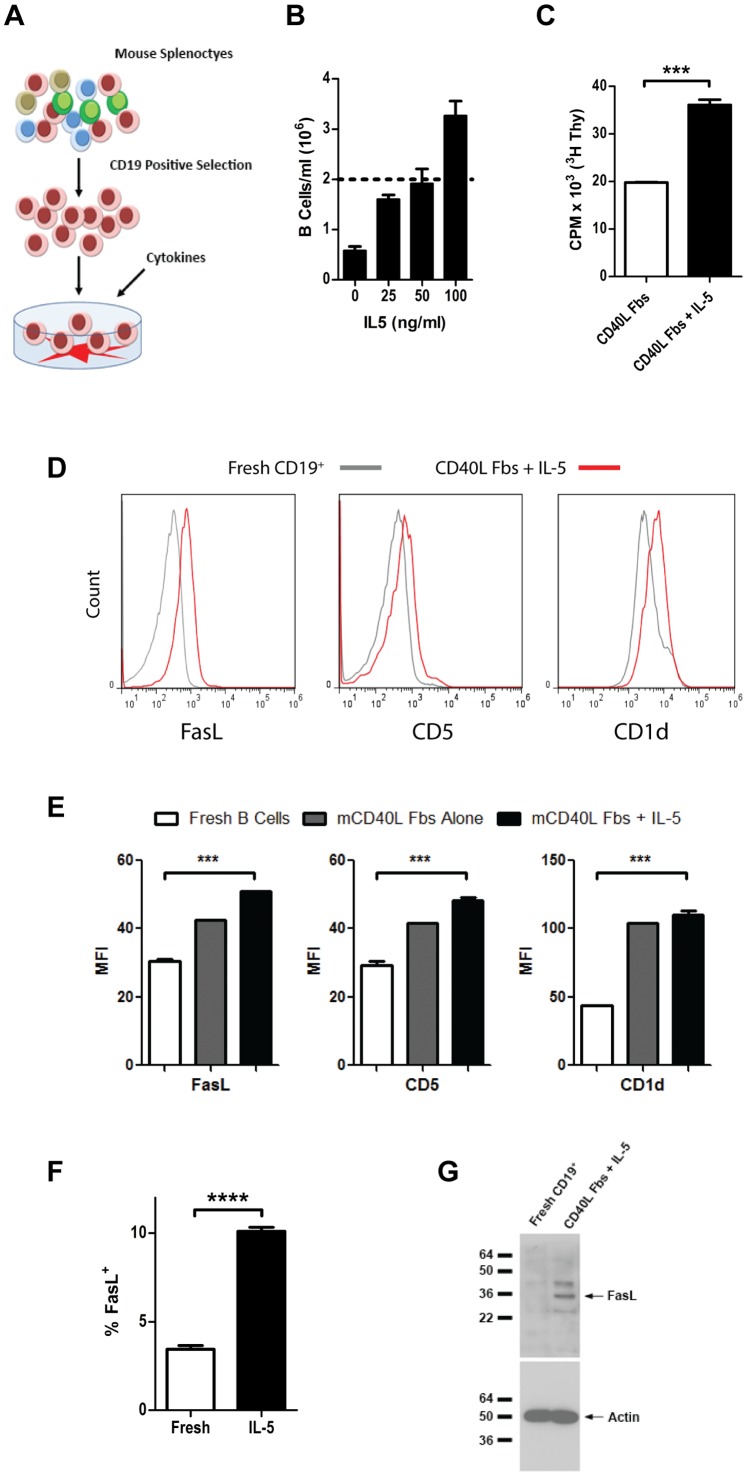
IL-5 and CD40L stimulation expands a population of B cells enriched for FasL expression.(A) Diagram of B cell co-culture experiments with CD40L-expressing fibroblasts for study of the effects of IL-5 on B cell growth and function. (B) CD19+ B cells were cultured as illustrated in (A) and harvested after five days. Viable B cells recovered from culture were quantified from replicate samples using a hemocytometer and trypan blue exclusion. The dotted line represents the concentration of B cells at the beginning of the experiment. (C) Proliferation of B cells cultured with CD40L-expressing fibroblasts in the presence or absence of IL-5 was assessed by the incorporation of 3H-thymidine. (D) B cells stimulated with CD40L in the presence or absence of IL-5 were stained for FasL, CD5, and CD1d and compared with freshly-isolated CD19+ B cells. (E) Median fluorescence intensity of surface markers stained as in (D) on freshly-isolated CD19+ B cells, B cells stimulated with CD40L, and B cells stimulated with CD40L and IL-5. (F) The frequency of FasL+ B cells among freshly-isolated CD19+ B cells and B cells stimulated with CD40L and IL-5 was measured by flow cytometry as in (D). (G) Cell lysates from equal numbers of freshly-isolated CD19+ B cells and IL-5-stimulated B cells were probed by immunoblot for FasL and β-Actin. Data are representative of more than four independent experiments. ***p<0.001.